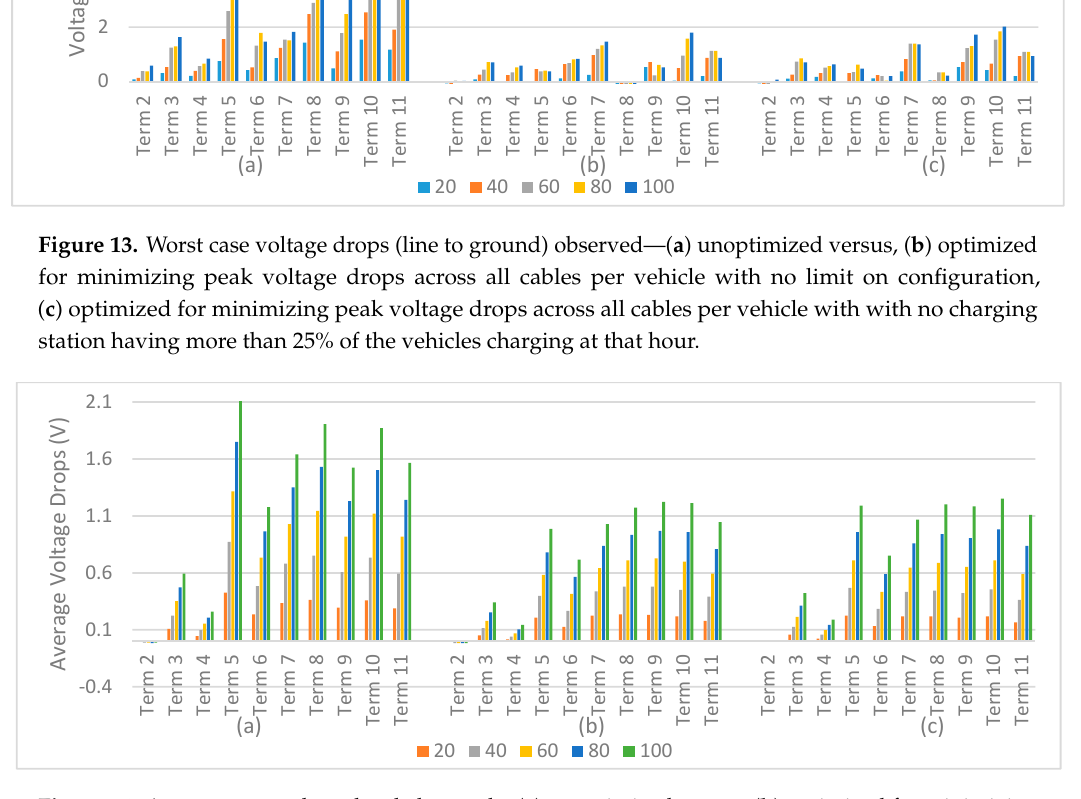
Figure 14. Average case voltage level observed—( a ) unoptimized versus, ( b ) optimized for minimizing peak voltage drops across all cables per vehicle with no limit on configuration, ( c ) optimized for minimizing peak voltage drops across all cables per vehicle with with no charging station having more than 25% of the vehicles charging at that hour.